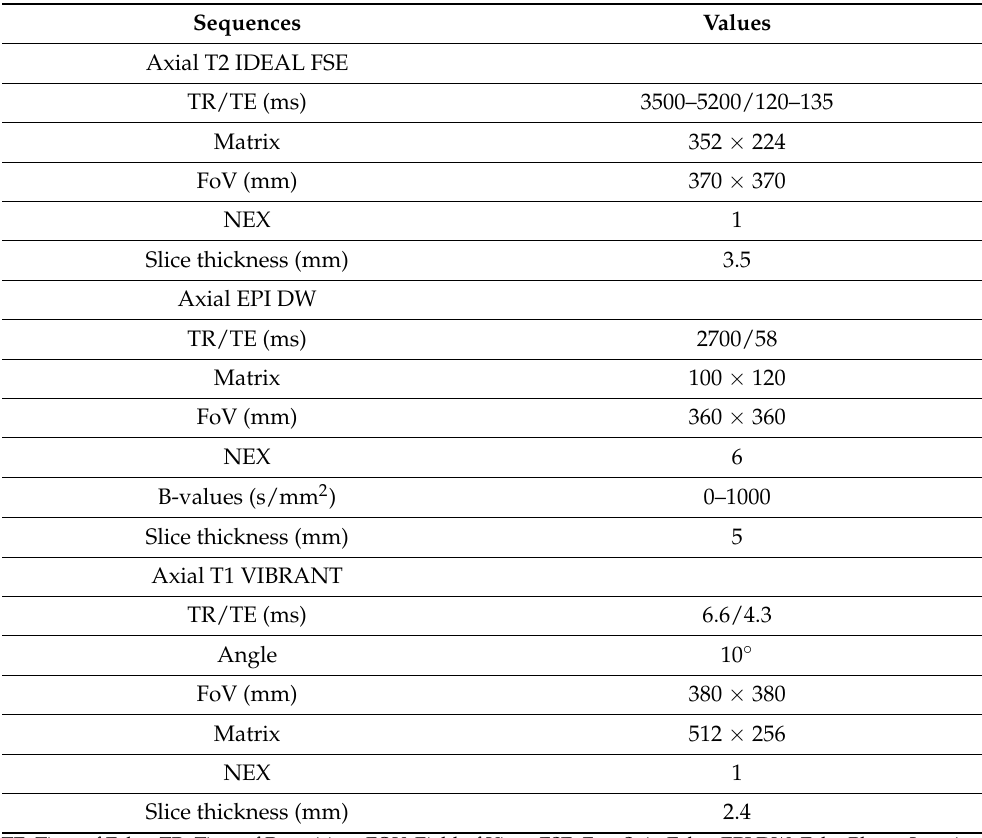
Table 1. Study protocol adopted for MRI